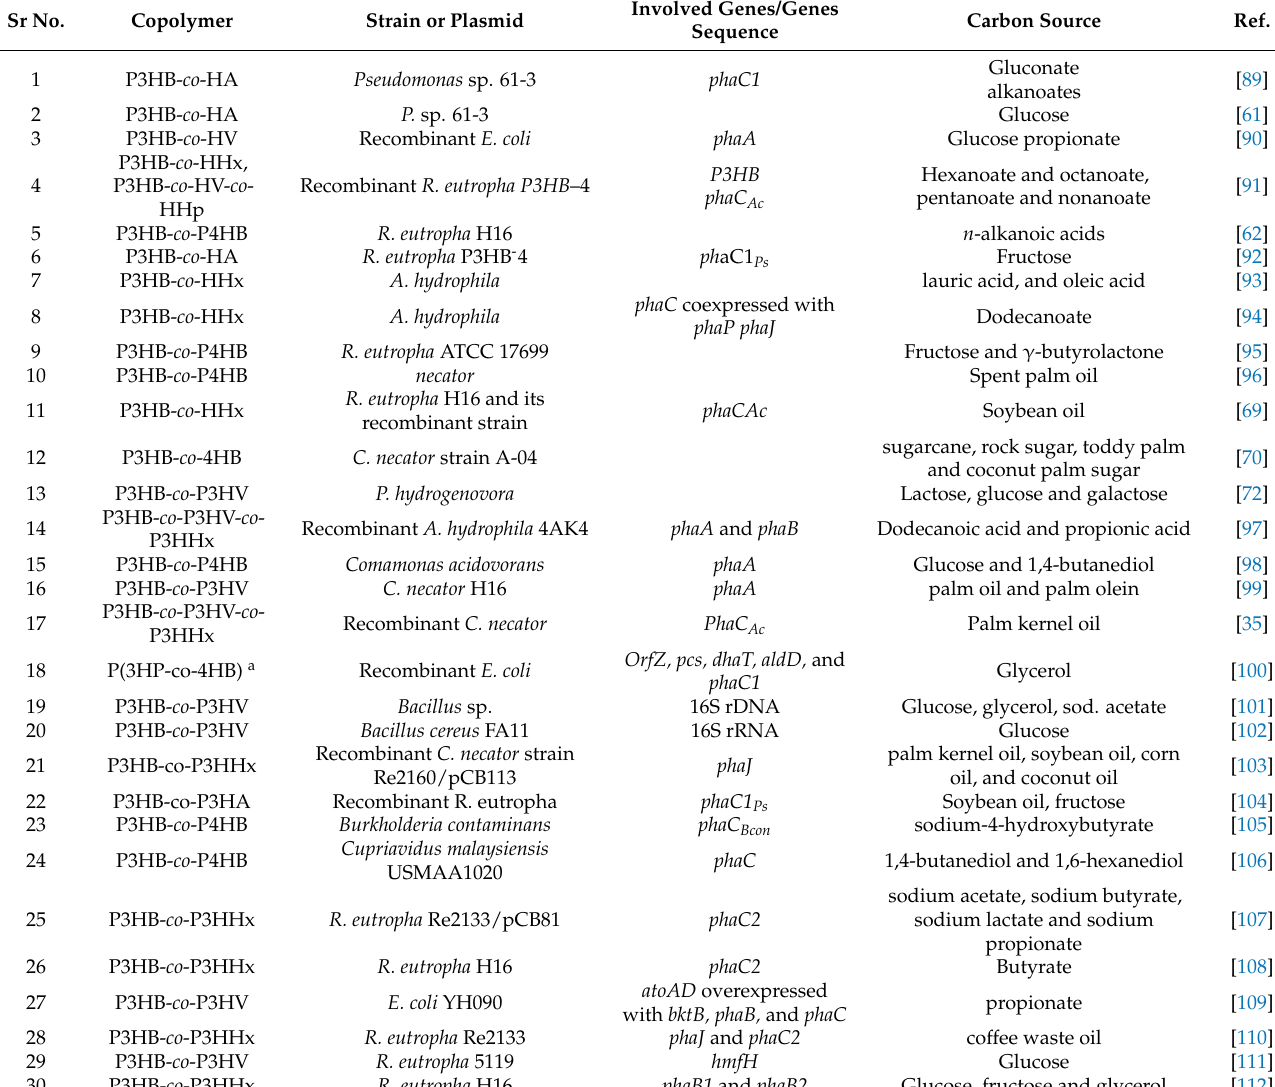
Table 4. Microbial production of PHAs